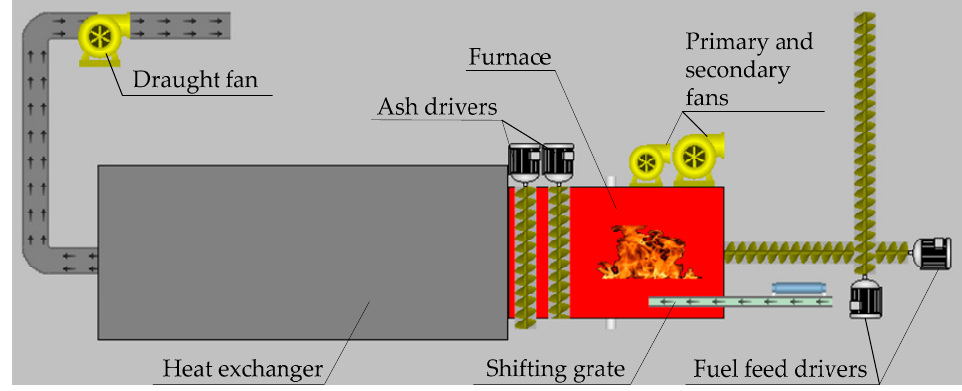
Figure 12. The sketch of 600 kW biomass-fired boiler.